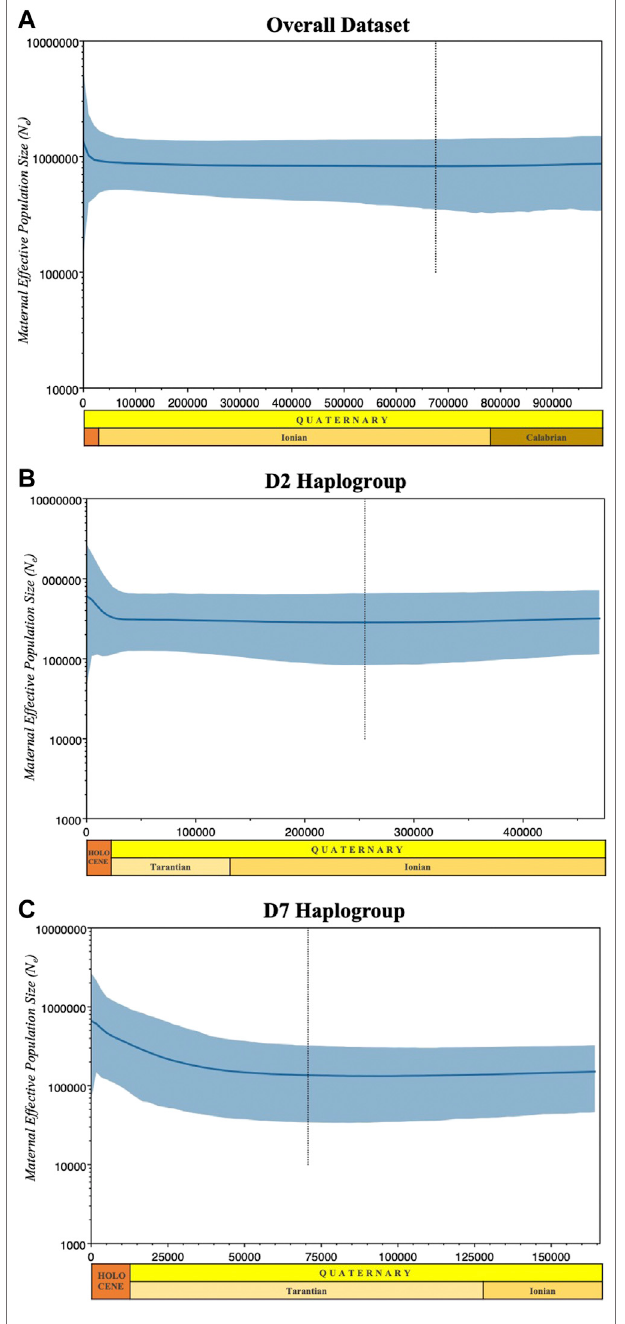
FIGURE6| Bayesianskylineplotsshowingtheeffectivepopulationsizes of the overall dataset (A) , the predominant (B) D2 and (C) D7 haplogroups. Median estimates of female effective population size ( N e ) are shown as a solid thick line (blue) and the light blue shaded area marks the 95% credibility intervals.Theabscissaisscaledinthousandsofyearsbeforethepresent(BP).